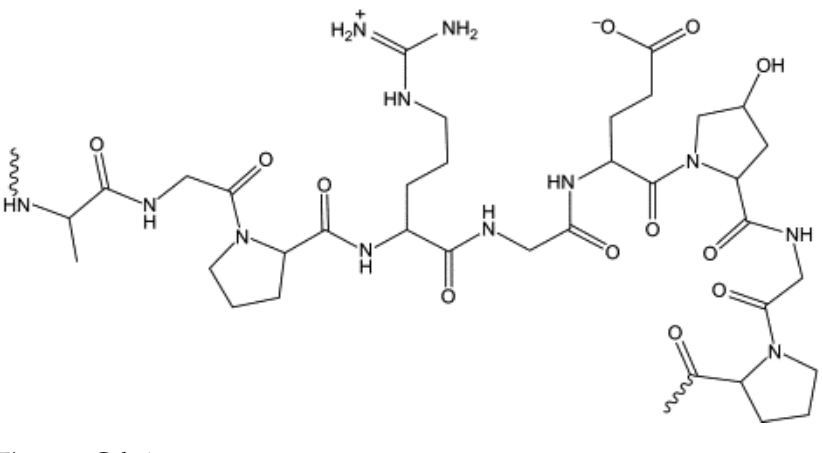
Figure 1. Gelatin structure.